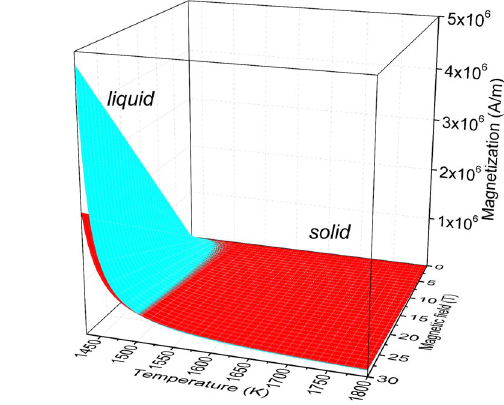
Figure 4. The calculated magnetization as a function of magnetic field intensity and undercooling temperature for solid Co during heating and liquid Co during